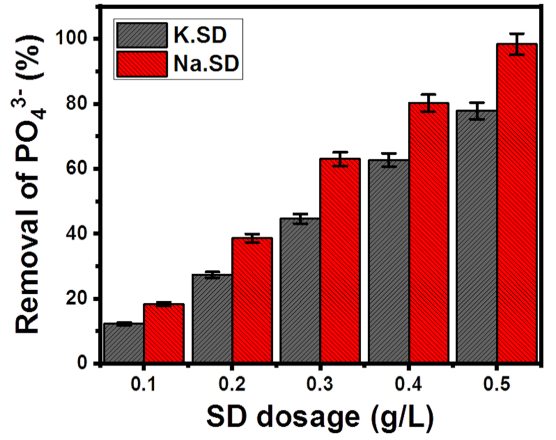
Figure 7. Effect of the K.SD and Na.SD dosages on the sequestration percentages of PO 43– (pH 6, 20 °C temperature, 50 mg L –1 phosphate concentration, and 960 min adsorption duration).